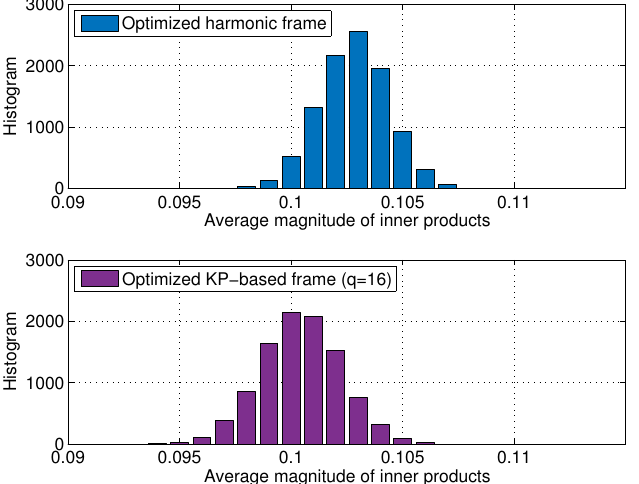
Figure 5. The distribution of average magnitude of inner products for 30-frame vectors randomly selected from the optimized harmonic and Kronecker-product-based frames, where N = 256 and m =